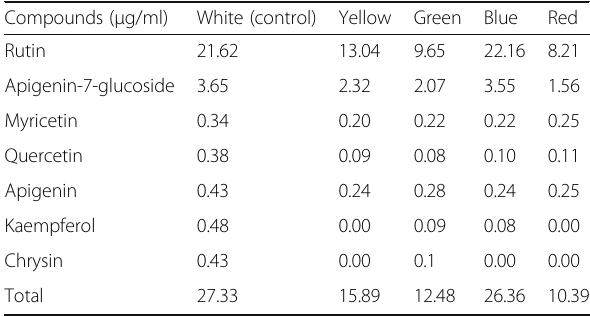
Table 4 Comparison of flavonoid under the five different light qualities on Ceratonia siliqua L Compounds ( μ g/ml) White (control) Yellow Green